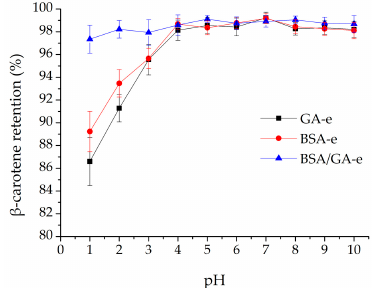
Figure 2. The effects of pH on the β -carotene retention of the three emulsions studied. The pH of the three emulsions studied were adjusted to 1, 2, 3, 4, 5, 6, 7, 8, 9, 10 separately and they were stored at room temperature without light for 2 h. Then β -carotene retention was measured after storage. Each data point is an average of triplicate, and the standard deviations are given.